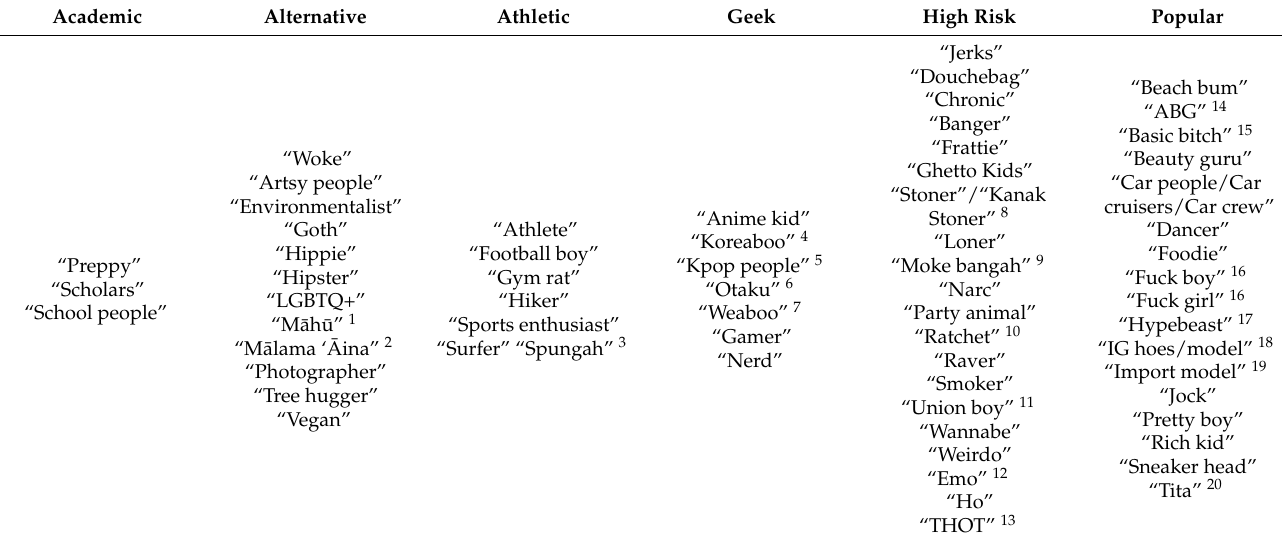
Table 2. Peer crowd names by